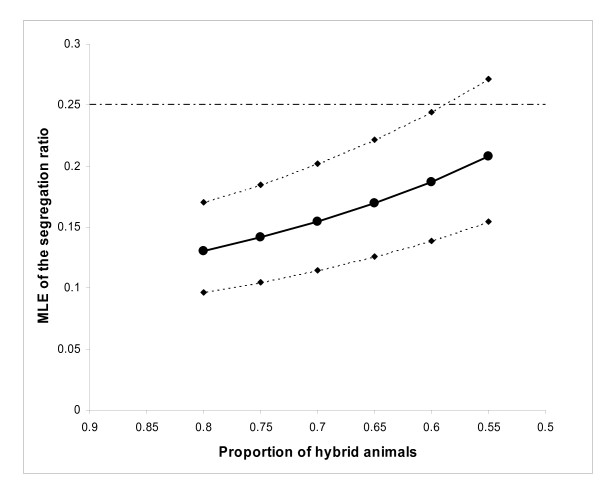
Expected fraction of Huacaya offspring. Huacaya segregation ratio in Suri × Suri crosses. Thick line: MLE of the segregation ratio R as a function of the proportion of segregating animals in the population. Dotted lines: 95% confidence limits of R.